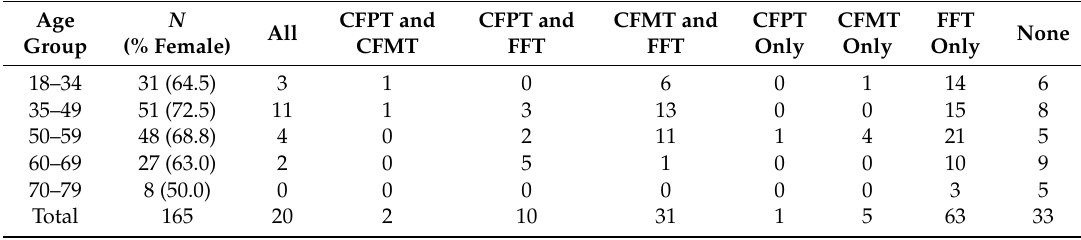
Table 3. Sample size of developmental prosopagnosia (DPs) in each age group, and number of participants that were impaired on the CFPT, CFMT and famous faces test